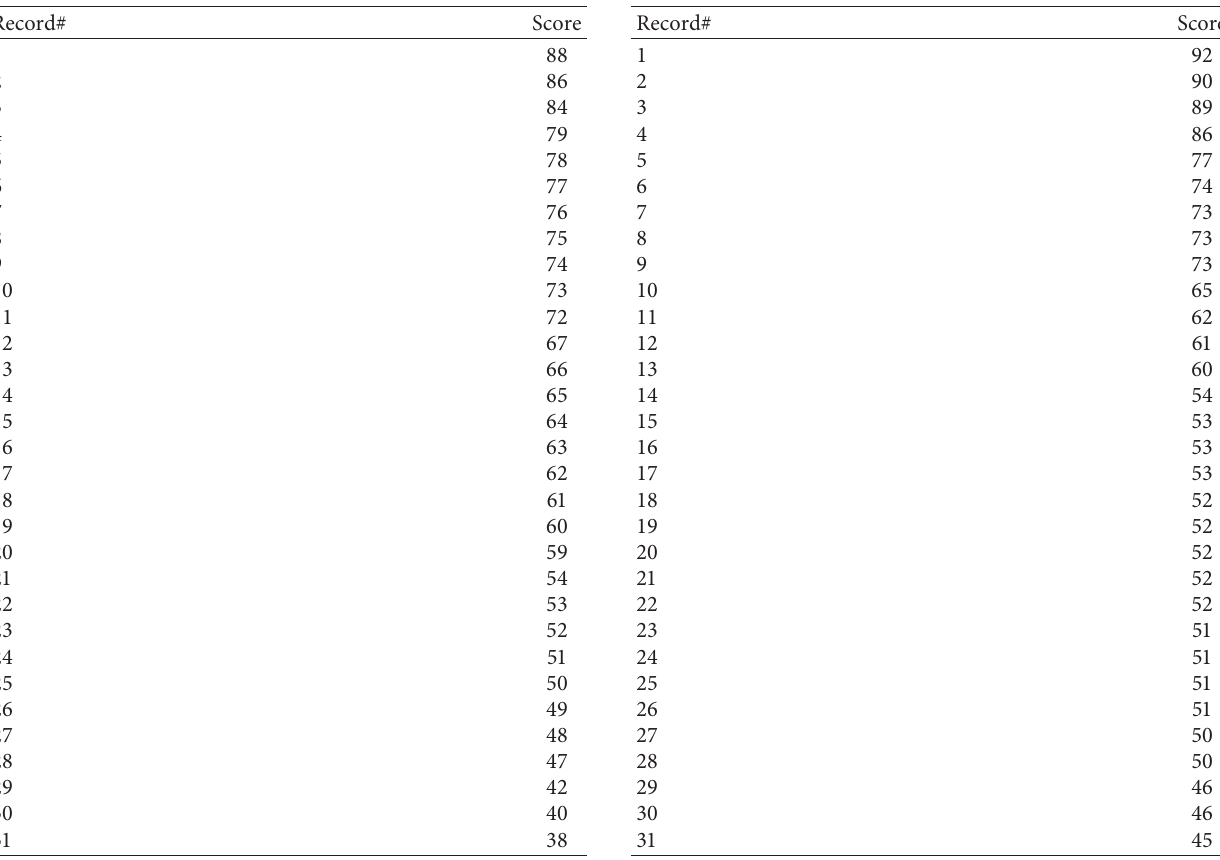
Table 2: Sorted scores of SD+ data set. Table 1: Sorted scores of ND data